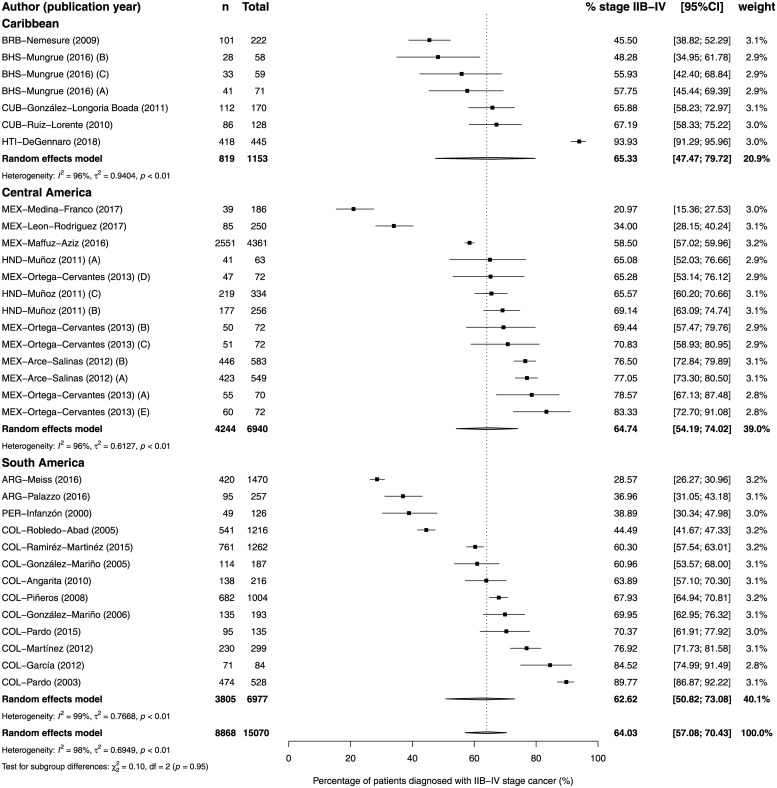
Forest-plot of percentage of stage IIb-IV breast cancer at diagnosis, by region of Latin America and Caribbean.Recruitment or diagnosis years: BHS-Mungrue (2016) A→C = 2009→2011; HND-Muñoz (2011) A = 1999 B = 2000–2004 C = 2005–2009; MEX-Ortega-Cervantes (2013) A→E = 2006→2010; MEX-Arce-Salinas (2012) A = 2008 B = 2009. Study references are given in the Supporting Information (S3 File).